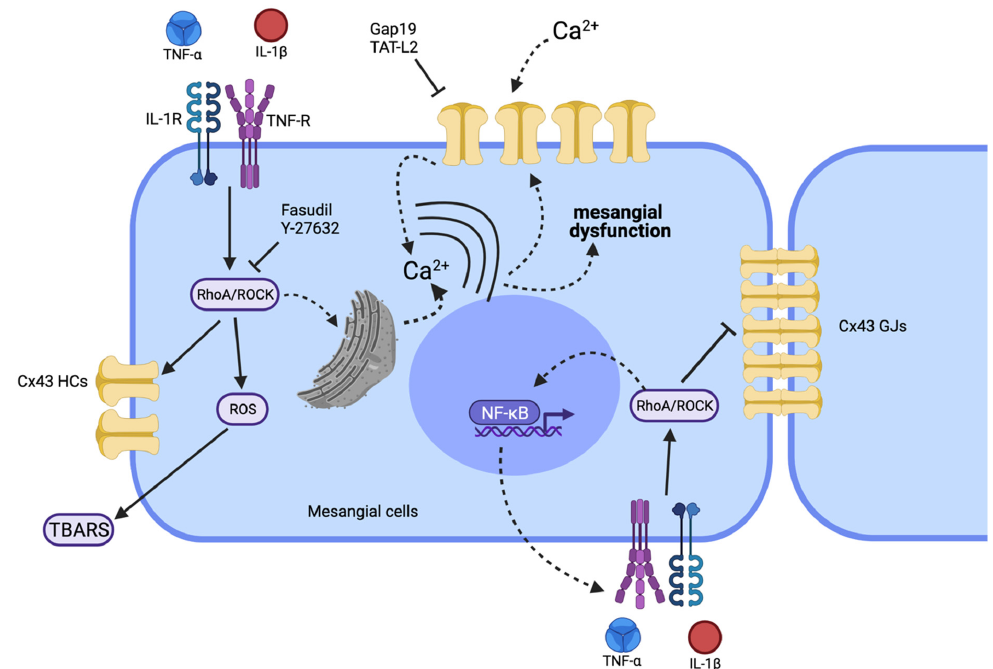
Figure 7. Schematic showing the possible signaling pathways involved in the TNF- α /IL-1 β -mediated regulation of the functional state of Cx43 HCs and GJs in mesangial cells. High TNF- α /IL-1 β concentrations could promote activation of a RhoA/ROCK-dependent pathway through TNF- α /IL- 1 β receptors (TNF-R and IL-1R) (continuous black arrows). Once the RhoA/ROCK-dependent pathway is activated, the formation of reactive oxygen species (ROS) takes place (generating TBARS) along with NF- κ B-dependent production of proinflammatory cytokines such as TNF- α and IL-1 β . The activated RhoA/ROCK-dependent pathway could increase the activity of Cx43 HCs, since Fasudil or Y-27632 (ROCK blockers) inhibit this response. The resulting increase in [Ca 2+ ] i will also activate Cx43 HCs, allowing the increase in Ca 2+ influx. The latter results in the rise of [Ca 2+ ] i and further generation of ROS. The influx of Ca 2+ establishes a positive feedback loop sensitive to different compounds such as the mimetic peptides Gap19 and TAT-L2, selective Cx43 HC blockers. This increase in the cellular activity caused by TNF- α /IL-1 β , where the RhoA/ROCK pathway could be involved, also reduces cell–cell communication through GJs. Of note, alterations in [Ca 2+ ] i homeostasis mediated by Cx43 HCs or Panx1 HCs might affect diverse aspects of MC functions (e.g., morphology and proinflammatory profile). Discontinuous black arrows indicate cell responses identified in other systems, whereas straight black arrows denote responses identified in the present work. Elaborated in